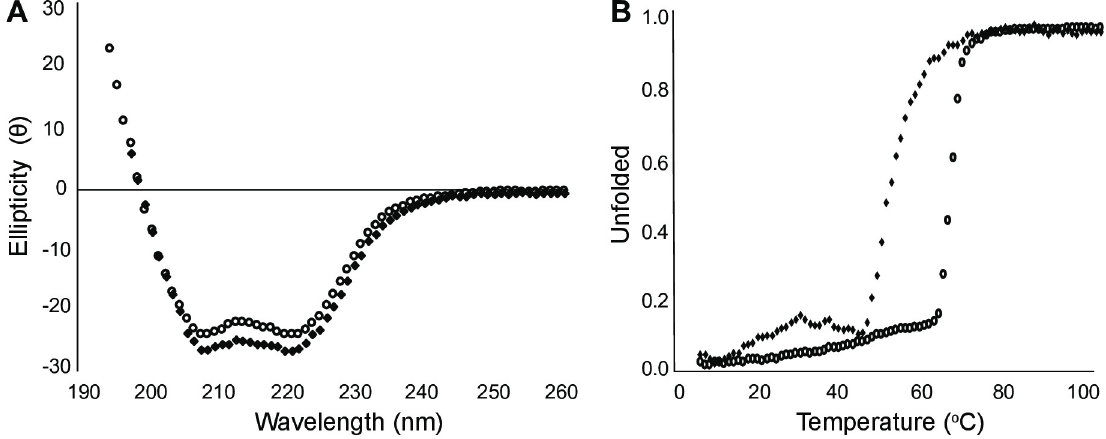
Fig 1. Circular dichroism spectra for E6AP C-lobe (wild-type— � , I827K substitution— ◆ ). A) Wavelength scans of the E6AP C-lobe constructs show similar secondary structure content at 10˚C. B) Melting curves show the E6AP C-lobe -I827K substitution has a lower the Tm (47.7˚C) than wild-type E6AP C-lobe